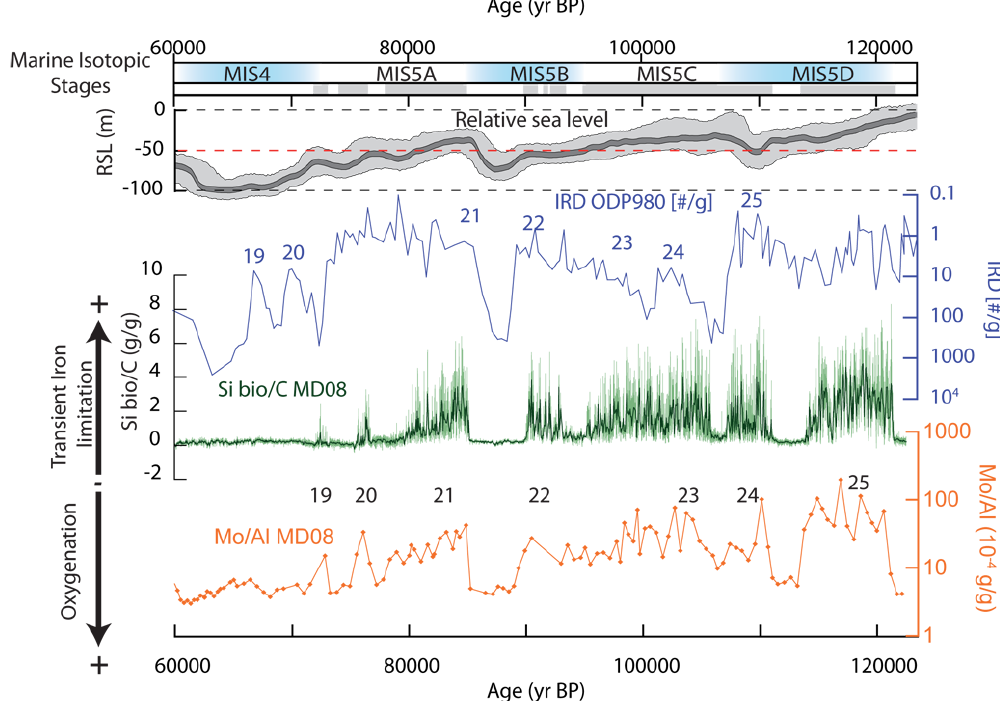
Fig. 5. The global relative sea level (Grant et al., 2012). Confidence interval of 95% (light grey) and probability maximum (dark grey) are indicated. The 50m depth below modern sea level, corresponding to modern Bering Strait depth is highlighted in red. The Ice Rafted Debris content in North Atlantic ODP site 980 core plotted on an inverse logarithmic scale (Oppo et al., 2006), and the biogenic Si to C ratio (Si bio /C) and Mo/Al in MD02-2508